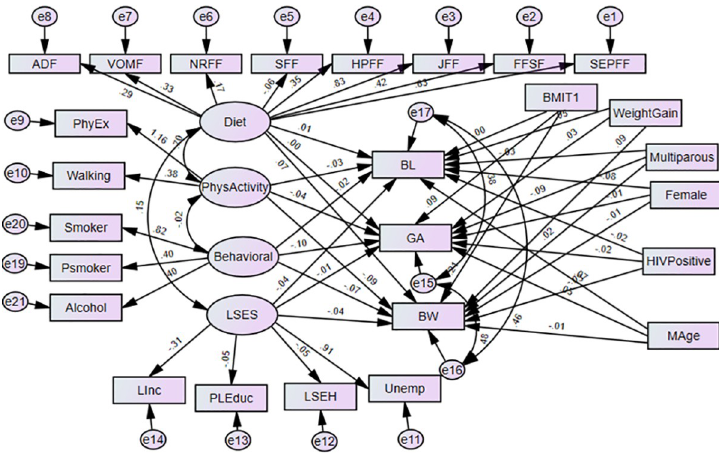
Fig 1. Structural equation model of direct effects of prenatal exposure characteristics on infant’s birth outcomes. BW-Birthweight; BL-Birth length; GA- Gestational age; NOx- Oxides of Nitrogen; GWG- gestational weight gain; BMIT1- pre-gestational body mass index in the first trimester; and Mage- maternal age. Latent variables: dietary factors (EFSF- energy foods and snacks; FFSF-spreads and fast foods; JFF- junk foods factor; PRFF-protein-rich foods; SFF- starch foods; NRFF-nuts and rice foods; VRFF-vegetable-rich foods; and ADF-alcoholic drinks); PhyEx- physical exercise; PSmoker- passive smoker; LSES -low socio-economic status, Linc- Low income; PLEduc- primary or less education; LSEH-Low socio-economic housing; Unemp- unemployed.